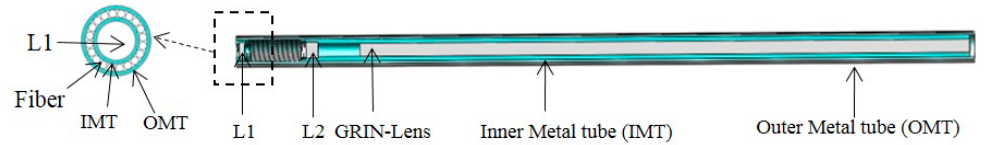
Figure 2. Front (left) and cross-sectional (right) views of the probe. L1: plano-concave lens − 9.8 mm; L2: achromatic doublet 10 mm; LMT: inner metal tube; OMT: outer metal tube.